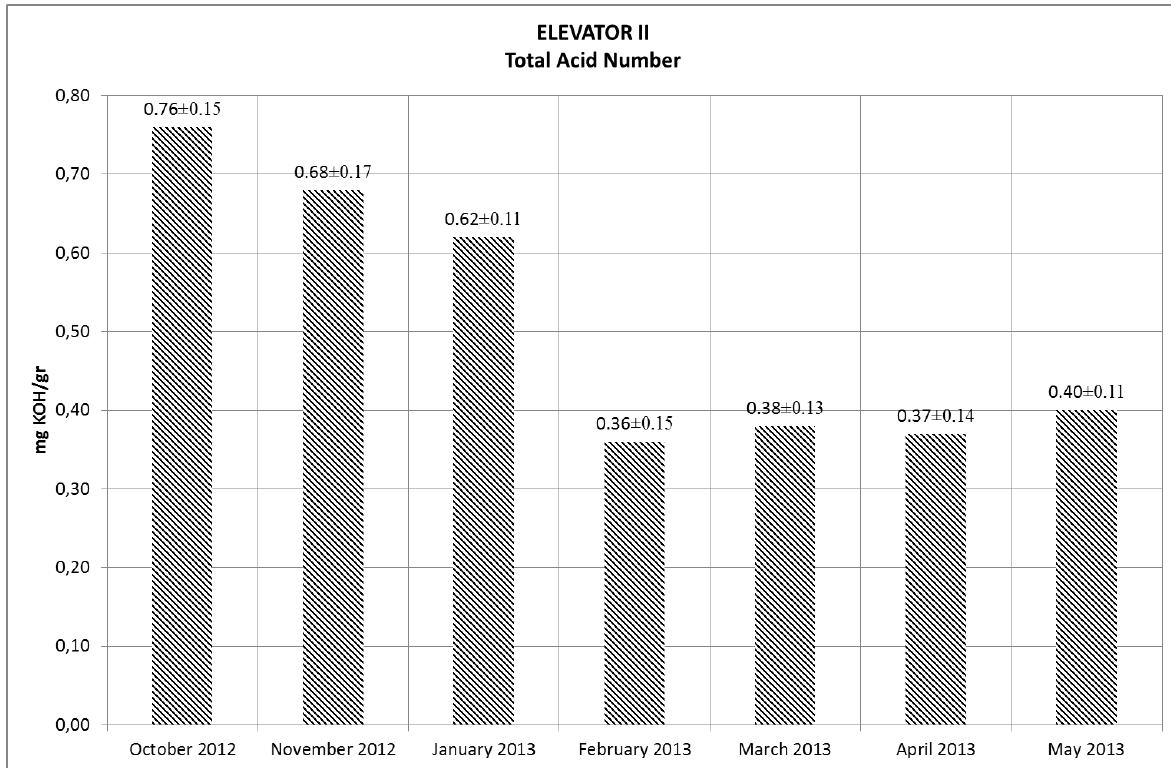
Figure 6. Total Acid Number of Elevator II.